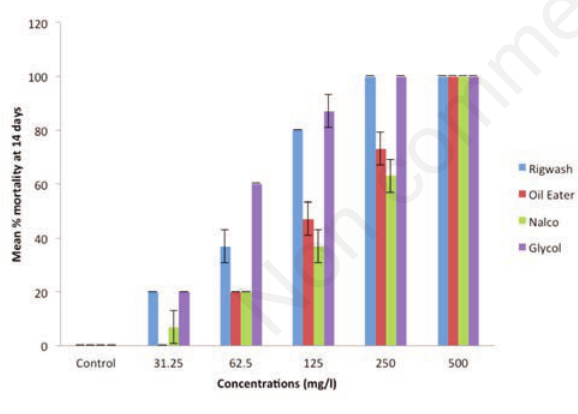
pesticides.Figure 1. Mortality (mean±standard error) of earthworms follow- ing a 14-day exposure to industrial